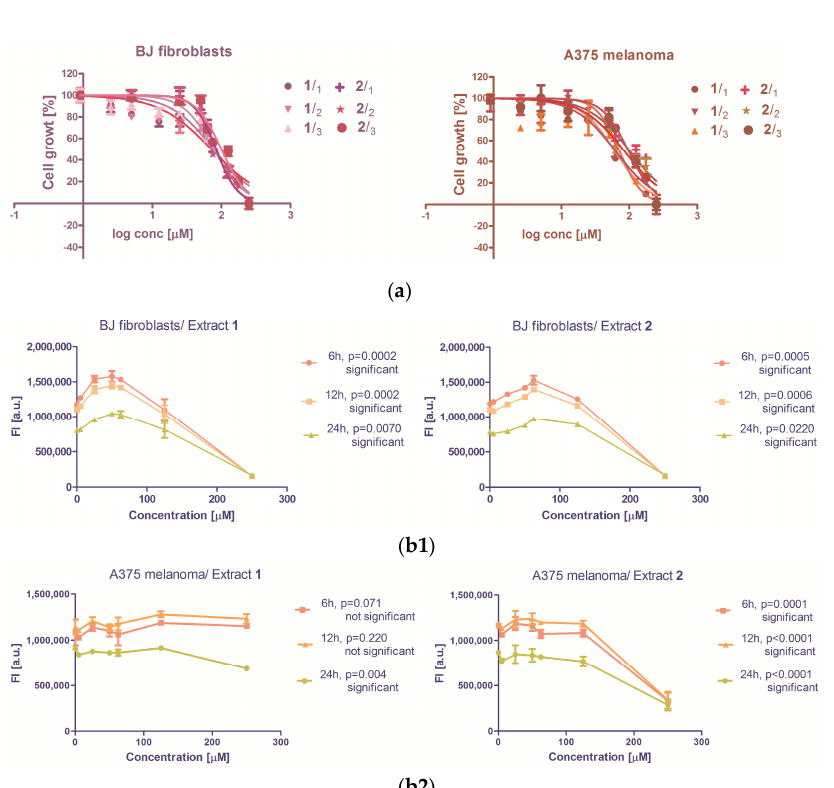
Figure 2. The in vitro effect of zeaxanthin-rich Goji extracts 1 and 2 on the cells survival, and proliferation; ( a ) sigmoidal dose-response relationship between the concentration of 1 and 2 and the inhibition of the cells growth during 24 h of exposure; ( b1 , b2 ) linear dose-response relationship between the compounds concentration and metabolic activity-related Alamar Blue fluorescence (FI on y axis is the fluorescence intensity). The capacity of zeaxanthin from Goji extract to modulate the intracellular reducing potential in treated normal fibroblasts (BJ) and malignant melanoma (A375) population, quantified by linear regression in the 95% confidence interval (Figure 2). The statistical significance of the deviation from untreated cells, considered as concentration 0, was quantified using the hill slope, p being the quantification of the probability. The linear regression in the 95% confidence interval indicates significant decrease following the treatment, exception being the shorter, 6- or 12-h exposure of A375 cells. Considering that the Lycium barbarum extracts contain other bioactive compounds as well [41], and the different Goji cultivars display various phenolic patterns [42], they can influence 1 and 2 biologic activity even if the other phenols distribution in 1 and 2 is reduced in compari- son with the zeaxanthin. 3.3. The Extracts 1 and 2 Effect on CD44 and CD105 Markers The expression of CD44 membrane marker was abundant on BJ fibroblasts surface (89.51%), and the 24 h exposure to Goji-derived zeaxanthin 1 and 2 generated a slight increase (93.82% and 93.52%, correspondingly, Figure 3 and Table 3). In A375 cells, the untreated reference values were lower, but still 50.13% of the cells were CD44-positive, which decreased significantly (two-way analysis of variance in the 95% confidence in- terval) following the cells exposure to 1 (to 33.35%) and 2 (to 32.16%). The 24-h exposure to 1 and 2 augmented the secreted CD44 level in A375 cells, dissimilar to the shorter ex- posures: 6 h and 12 h give inconsistent or statistically insignificant changes. In BJ, only extract 2 was capable to increase the secreted CD44 level, after 24 h exposure (Figure 3), while none of the other exposure lengths was sufficient to significantly modulate CD44 secretion (one-way analysis of variances in the 95% interval). The influence of 1 and 2 on CD105-positive cells proportion was less significant (Figure 4). In A375 cells, the CD105 basal value was low (3.99%) and the action of extracts caused insignificant decrease (to 2.70 following 1 and 1.97 following 2 activities). In BJ cells, zeaxanthin 1 solution caused a decrease: from basal 18.83% to 13.72%, while the effect of 2 has had no significance on CD105 marker (17.73%). The cells in vitro CD105 secretor capacity was evaluated with Elisa testing (Figure 4); the A375 melanoma cells